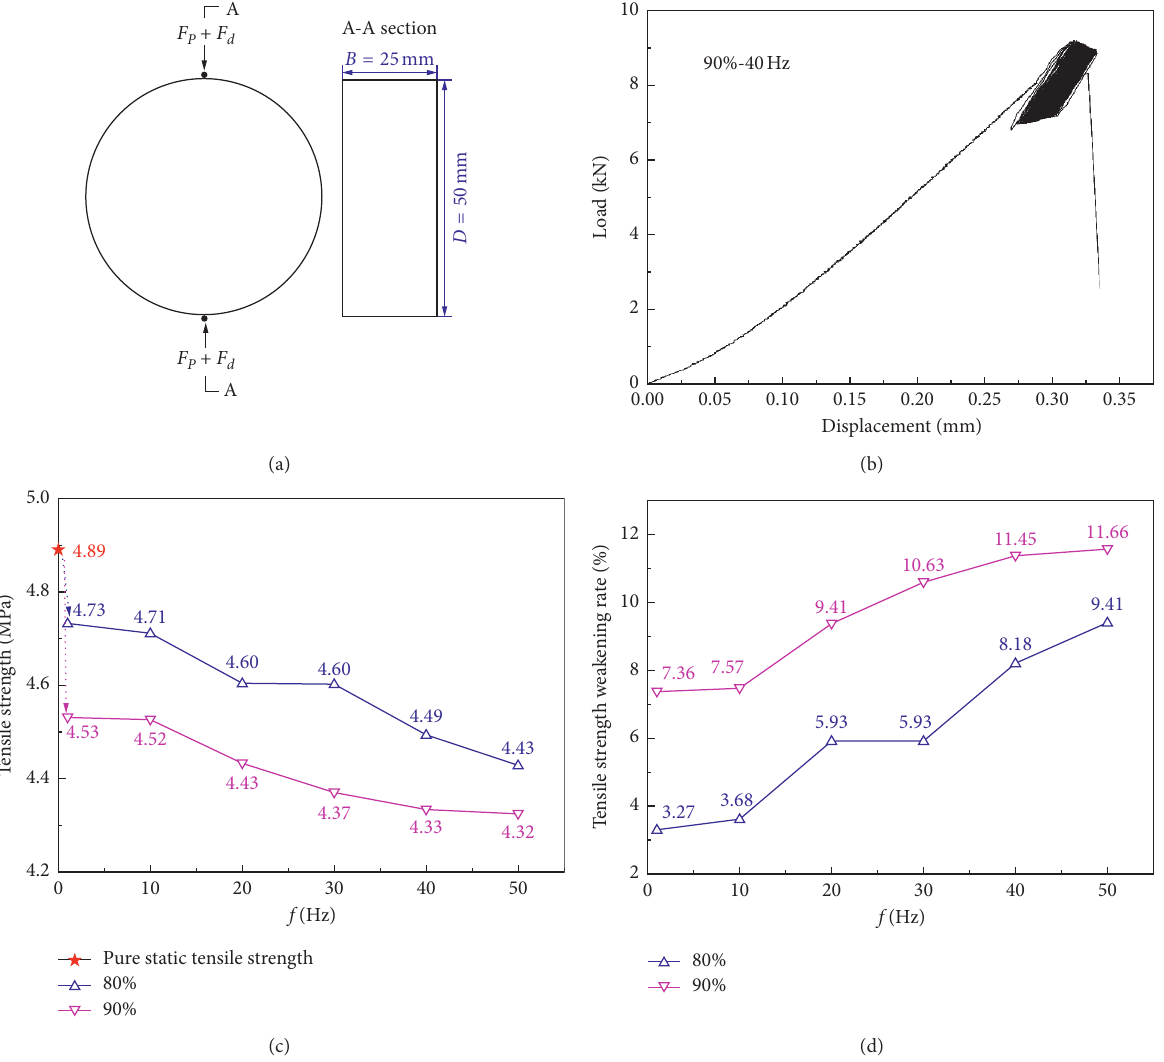
Figure 11: Test results of BD samples. (a) Sample size. (b) Typical load-displacement curve [32]. (c) Variation characteristics of tensile strength with disturbance frequency. (d) Variation characteristics of tensile strength weakening rate with disturbance